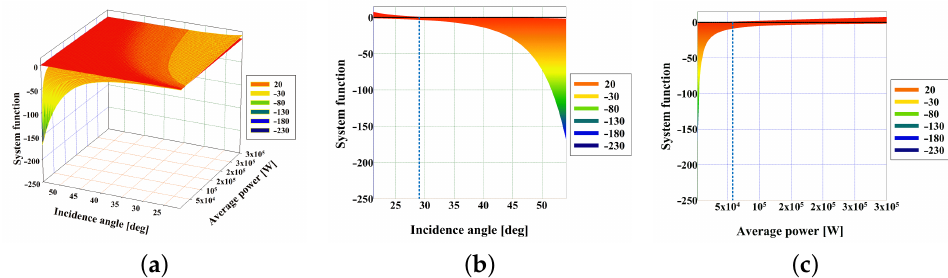
Figure 8. ( a ) When the number of multi-looks, satellite height, and scale factor of water ice are L look = 10, H sat = 100 km and 5%, the system function changes with the incidence angle φ and average power P av . ( b , c ) are the simulation results of the system function changing with φ and P av , respectively.